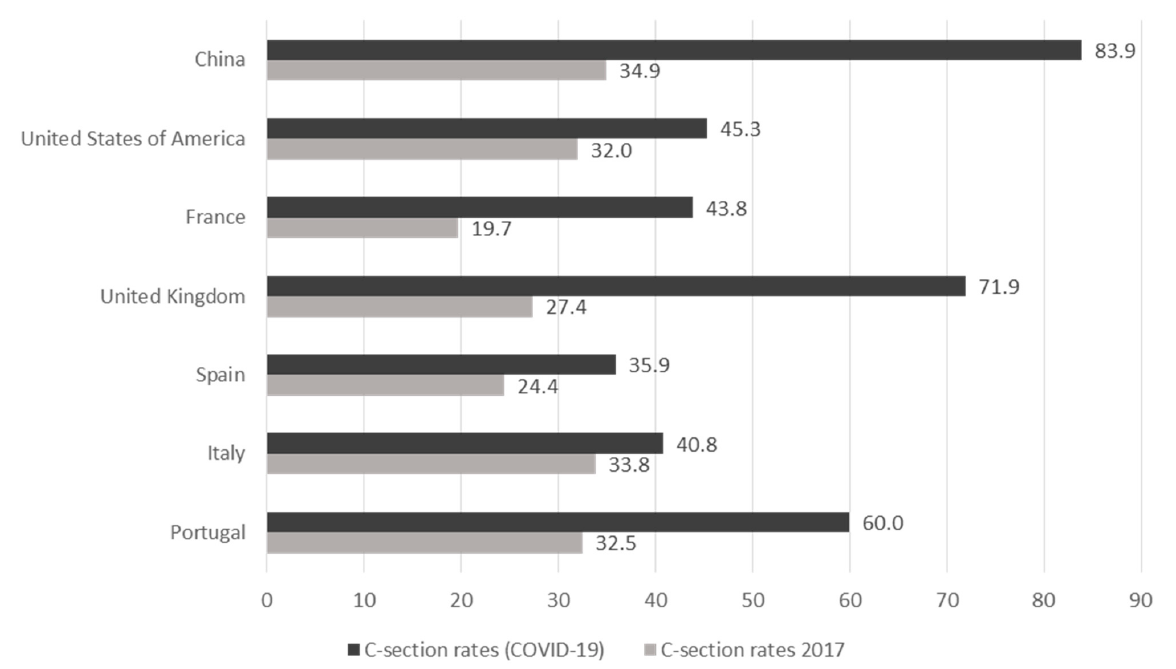
Figure 4. C-section rates in 2017 by countries [70] compared with C-section rates registered in the systematic review.